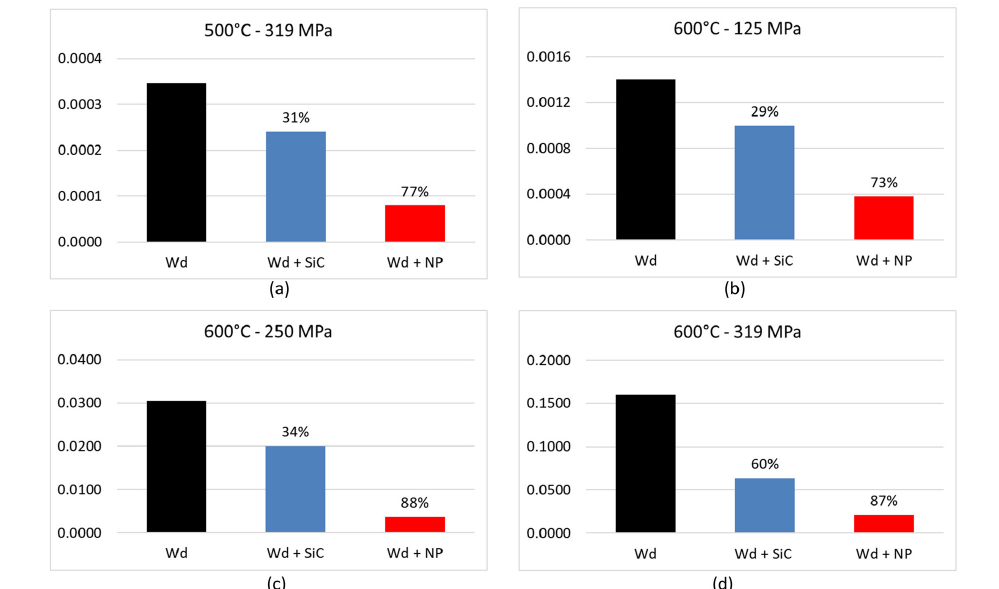
Figure 6. Comparison of the Ti-6Al-4V alloy creep rate reduction with Widmanstätten structure untreated (Wd) 21 , plasma nitrided (Wd + NP) 13 and SiC coated (Wd + SiC) 22 in the conditions: (a) 500 °C and 319 MPa, (b) 600 °C and 125 MPa, (c) 600 °C and 250 MPa and (d) 600 °C and 319 MPa.